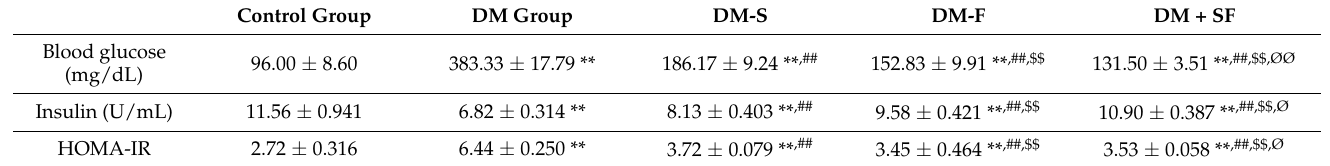
Table 1. Effect of exercise and dapagliflozin on glucose homeostasis in different groups data presented as mean ± standard deviation.